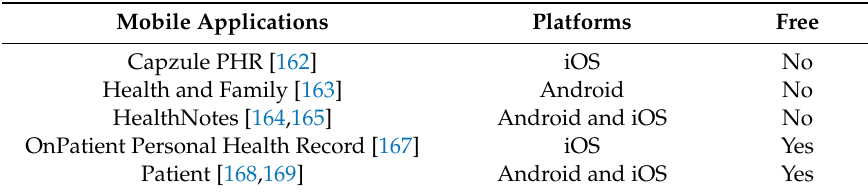
Table 6. Mobile health applications to check PHR.